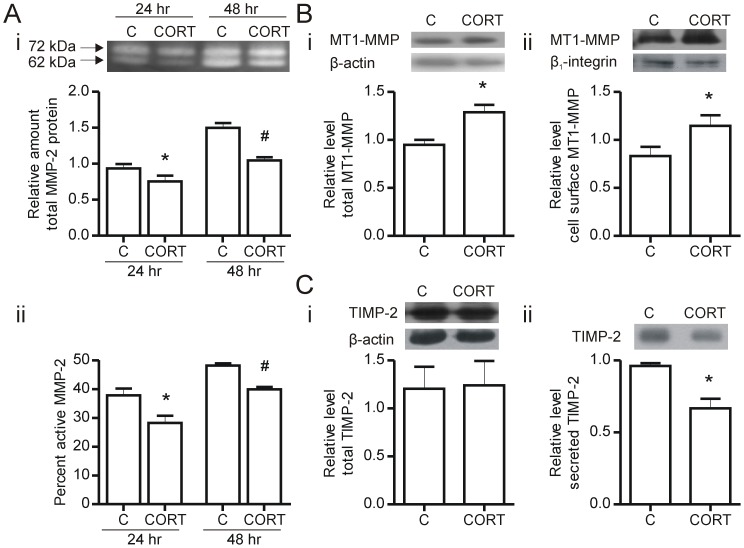
Corticosterone inhibits MMP-2 production and activation.Endothelial cells were resuspended in type 1 collagen at a density of 5.0×105 cells/ml, and treated with 600 nM corticosterone for 24 and 48 hours. Total (Ai) and percent active (Aii) MMP-2 levels in cell culture media were measured by gelatin zymography; (i) * p = 0.0446 vs 24 hr control, # p = 0.012 vs 48 hr control. (ii) * p = 0.0001 vs 24 hr control, # p = 0.008 vs 48 hr control, n = 4, respectively. (A). Total MT1-MMP was detected by immunoblotting of whole cell lysates (Bi) while cell surface MT1-MMP was detected by immunoblotting of cell surface biotinylated proteins (Bii) (*p = 0.006 vs control, n = 4; *p = 0.03 vs control, n = 4, respectively). Whole cell TIMP-2 levels (Ci) and secreted TIMP-2 (Cii) were detected by immunoblotting (*p<0.05 vs control, n = 3). C – Control, CORT – Corticosterone. N values represent independent experiments.